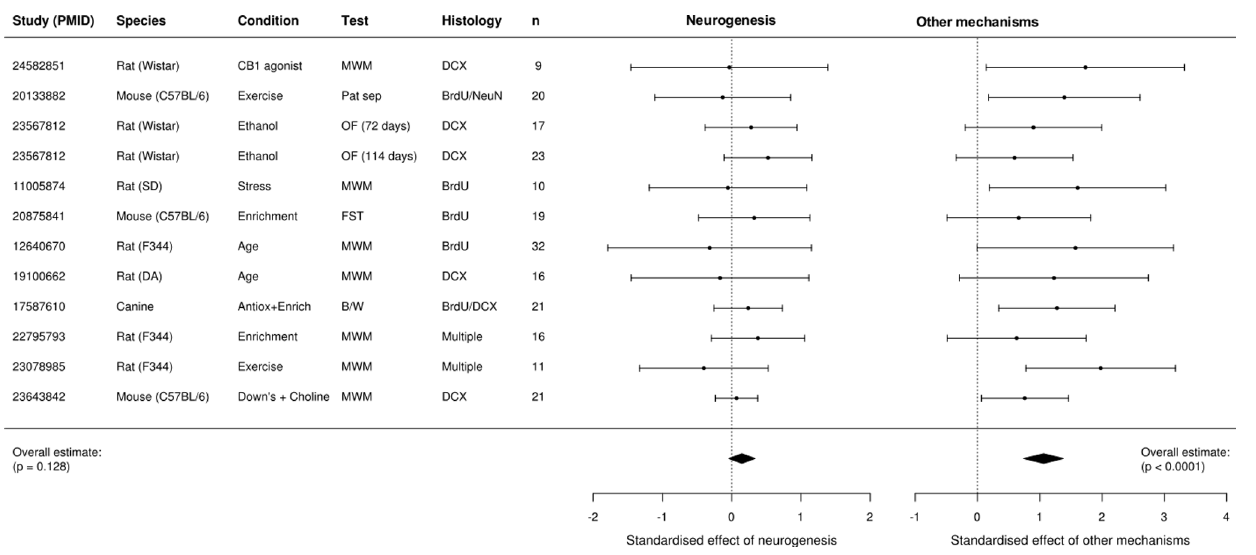
Figure 2. Study specific and combined estimates from the causal mediation analysis. The effect of neurogenesis was smaller than the effect of other mechanisms in all studies. The overall effect of neurogenesis was small, non-significant (p 5 0.128), and unlikely to account for a large proportion of the observed behavioural effects (upper 95% CI 5 0.34). PMID 5 PubMed ID; DA 5 Dark agouti; SD 5 Sprague-Dawley; MWM 5 Morris water maze; OF 5 open field; FST 5 forced swim test; B/W 5 black/white discrimination task. Error bars are 95% credible